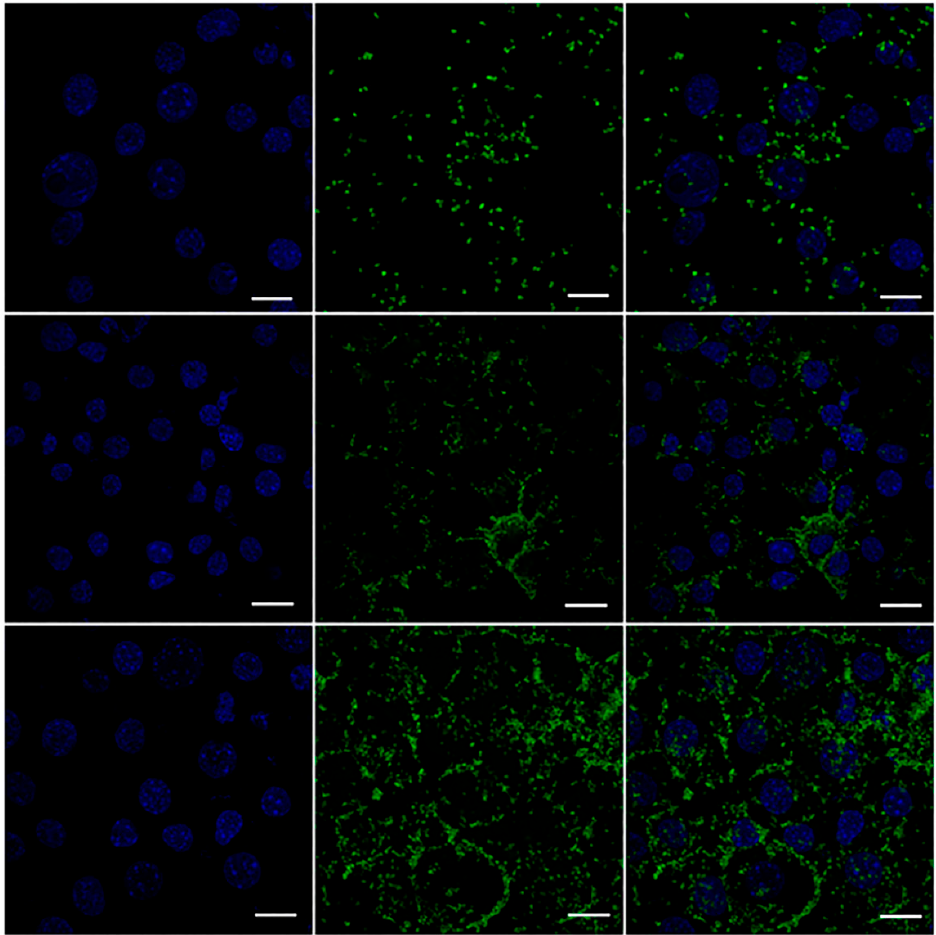
Figure 11. CLSM image of RAW 264.7 macrophage cells incubated with MPIEDFITC. For each panel, the images from left to right show cell nuclei stained by DAPI (blue), the fluorescence of the labelled conjugate (green) and overlays of the two images. Scale bar = 10 µm.